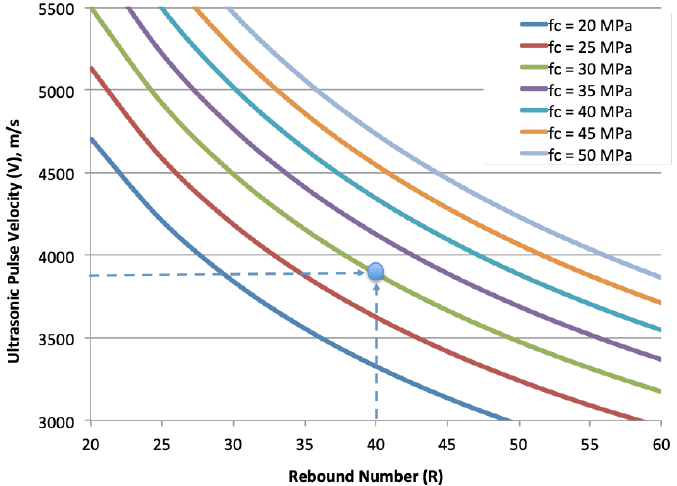
Figure 1. Graphical representation of the SonReb model using Equation (1) [7].